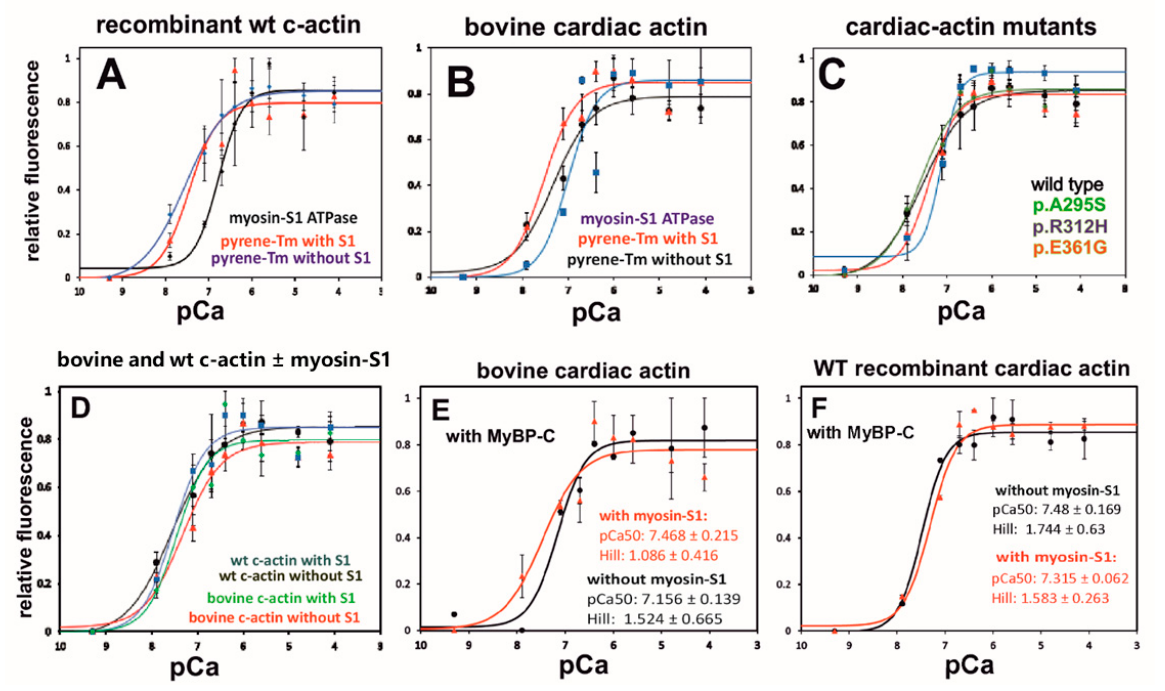
Figure 8. Comparison of the Ca 2+ -concentration dependence of the fluorescence increase (movement) in pyrene-labeled cTm on bovine and recombinant c-actin variants. Table 5. Parameters of the Ca 2+ -ion dependence of fluorescence increase in pyrene-cTm (i.e., cTm